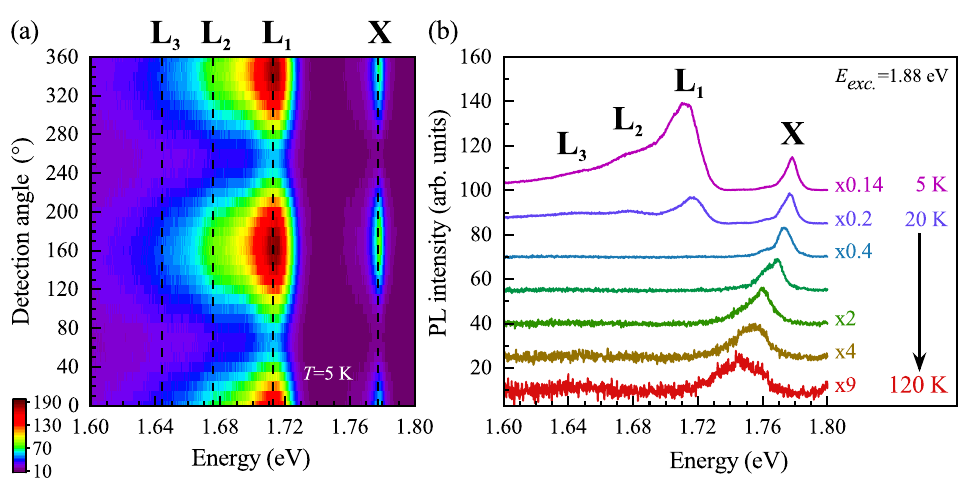
Figure 3. ( a ) False-color map of low-temperature PL spectra of GeS as a function of the detection angle of linear polarization under 1.88 eV laser light excitation. ( b ) Temperature evolution of the PL spectra measured on GeS. The spectra are vertically shifted for clarity and some of them are multiplied by scaling factors for more